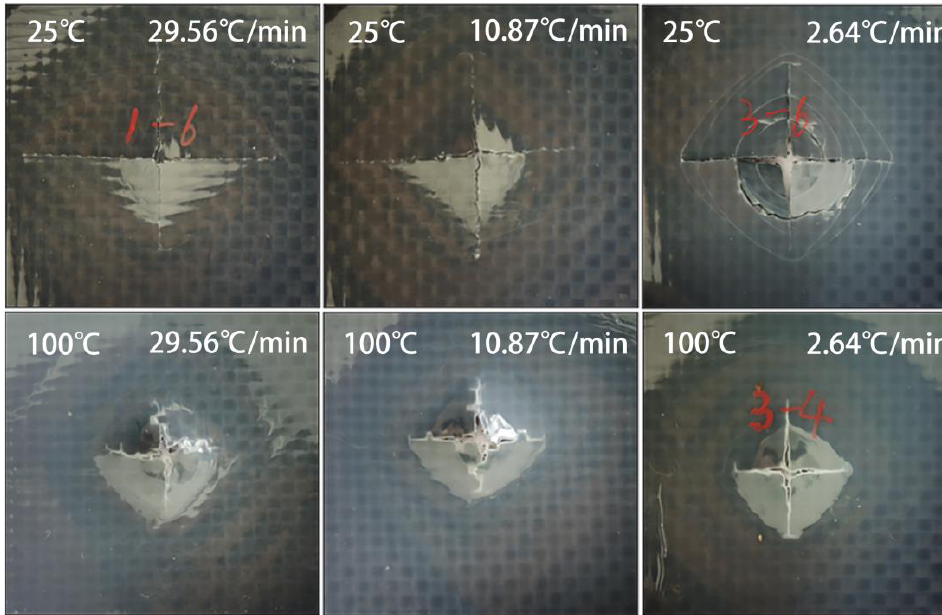
Figure 12. Destruction morphology of a sample of each cooling rate after the QSI test.